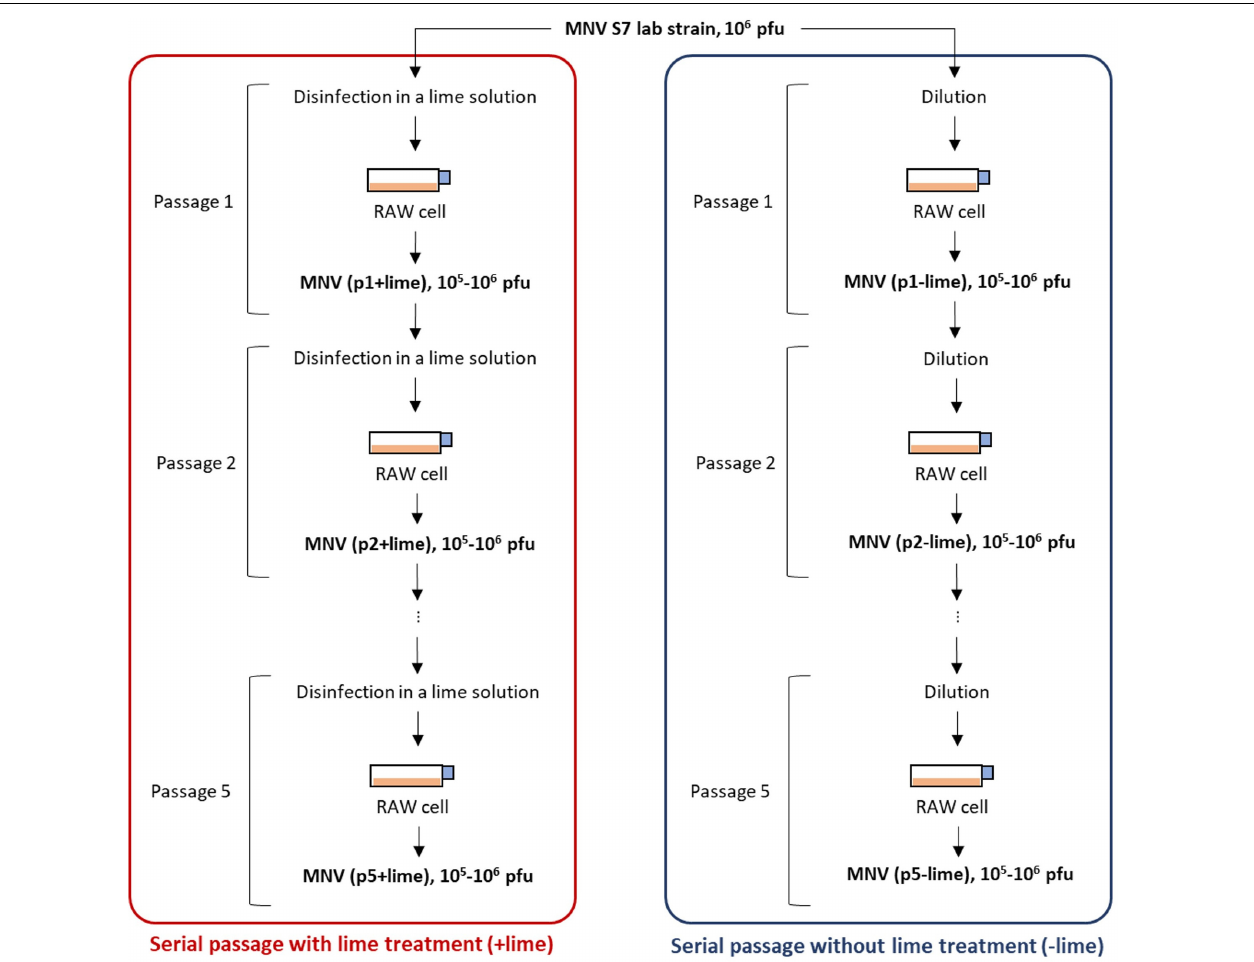
FIGURE 1 | Schematic depiction of serial passages as performed in experimental adaptation of murine norovirus (MNV). Once an initial infection is completed in plate 1, the virus is titrated and the desired amount is used to infect the cells in plate 2. The process was repeated five